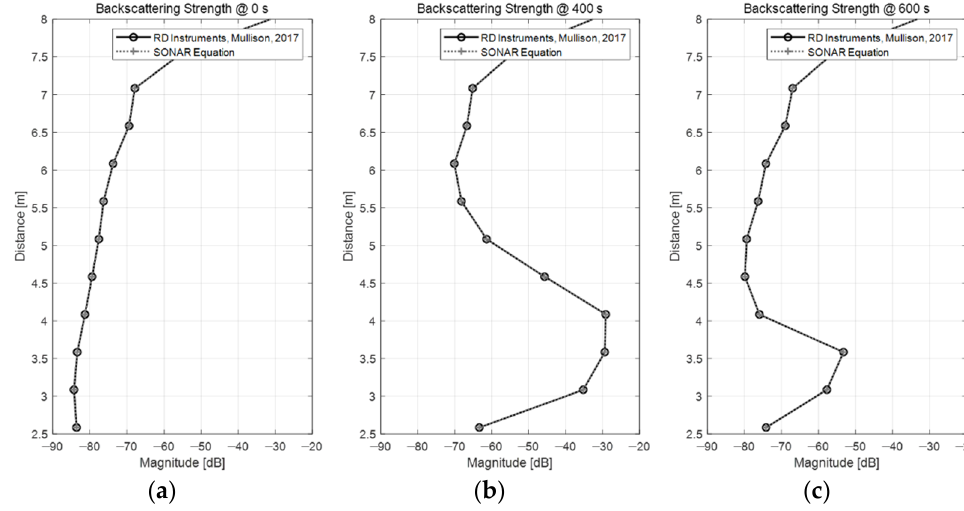
Figure 4. Comparison of backscattering strengths obtained through two different approaches: ( a ) 0 s; ( b ) 400 s; and ( c ) 600 s, respectively. The solid and dashed lines overlap almost perfectly in the figures. In Figure 4, the black solid line represents the backscattering strength obtained with the method provided by the manufacturer, whereas the gray dashed line shows the results